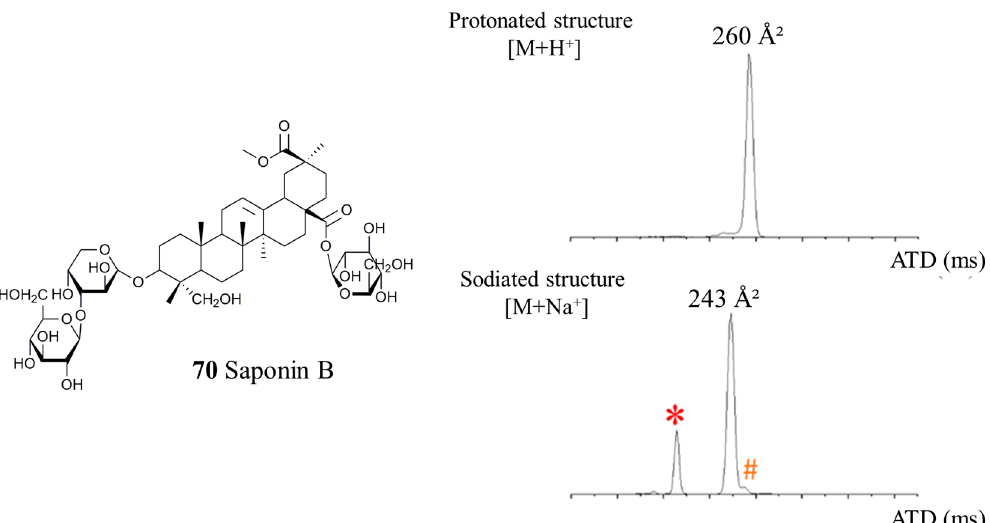
Figure 5. Ion mobility experiments on quinoa saponin ions: Arrival Time Distributions (ATD) of protonated ( m / z 973) and sodiated ( m / z 995) Saponin B. The TW CCS N2 ⭢ He presented at the top of the